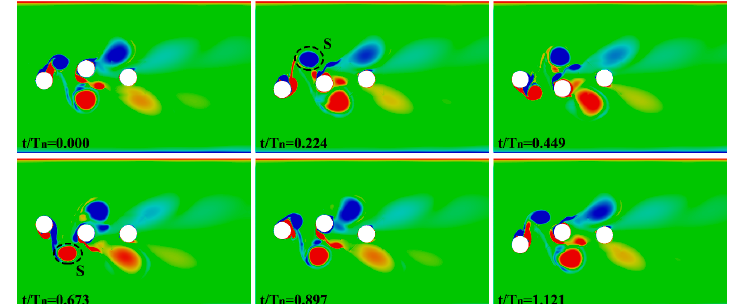
Figure 8. Near-wake structure of the three cylinders when Re = 30,000.